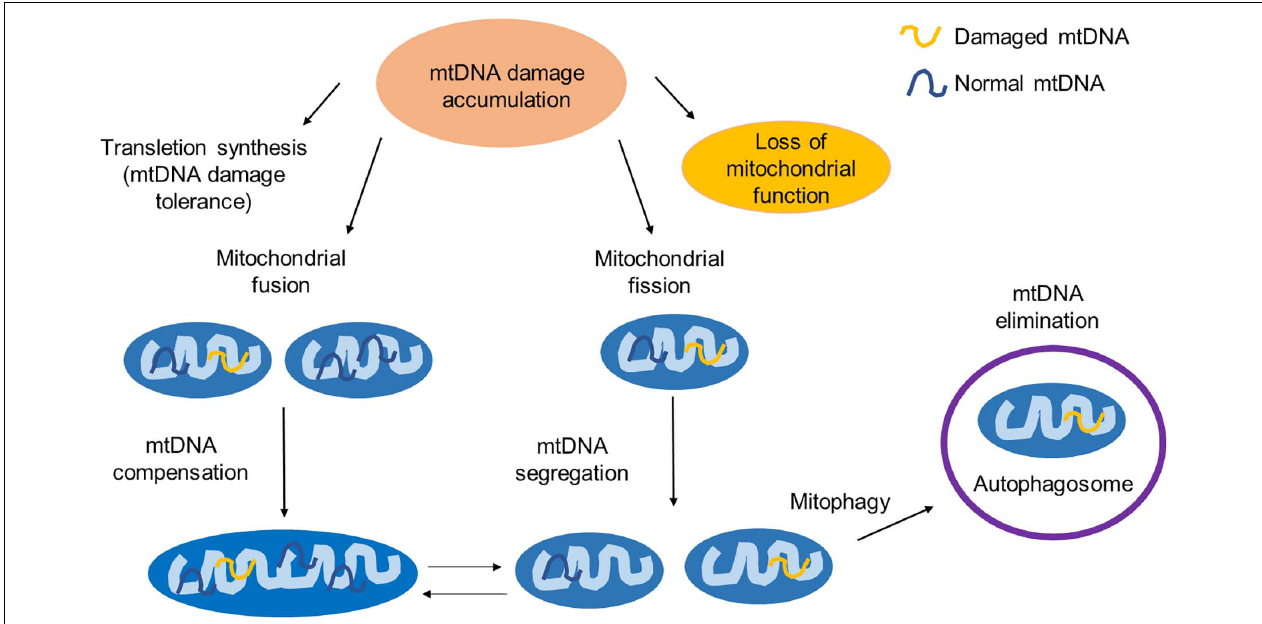
FIGURE 2 | The mitochondrial response to unrepaired DNA damages. Unrepaired mtDNA damages can be accumulated and lead to the mitochondrial dysfunction. To maintain its function, the mitochondria have developed several quality control events. TLS is an mtDNA damage tolerance pathway to bypass the mtDNA replication block. Mitochondrial fusion provides mtDNA complementation by mixing damaged and normal mtDNA. Mitochondrial fission segregates the part of a mitochondrion with damaged mtDNA and maintains the integrity of the healthy part of a mitochondrion. Mitochondria with excessive damaged mtDNA are selectively degraded through mitophagy. The interaction between the mitophagy and the mitochondrial fission/fusion has also been